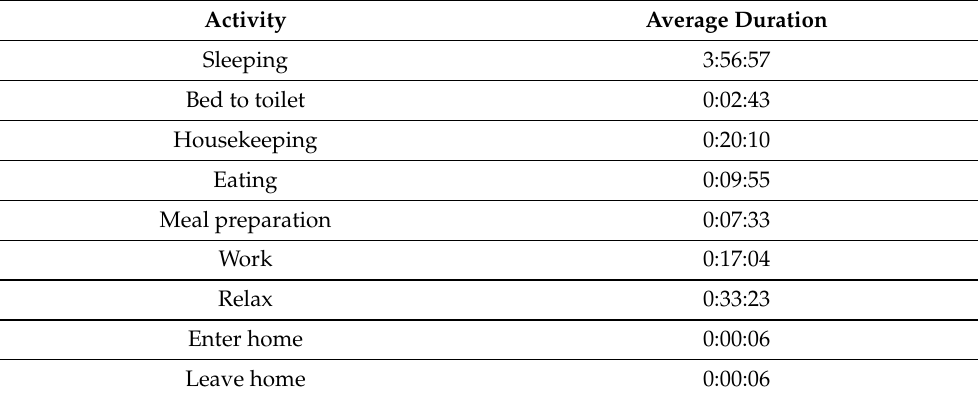
Table 1. Average duration of